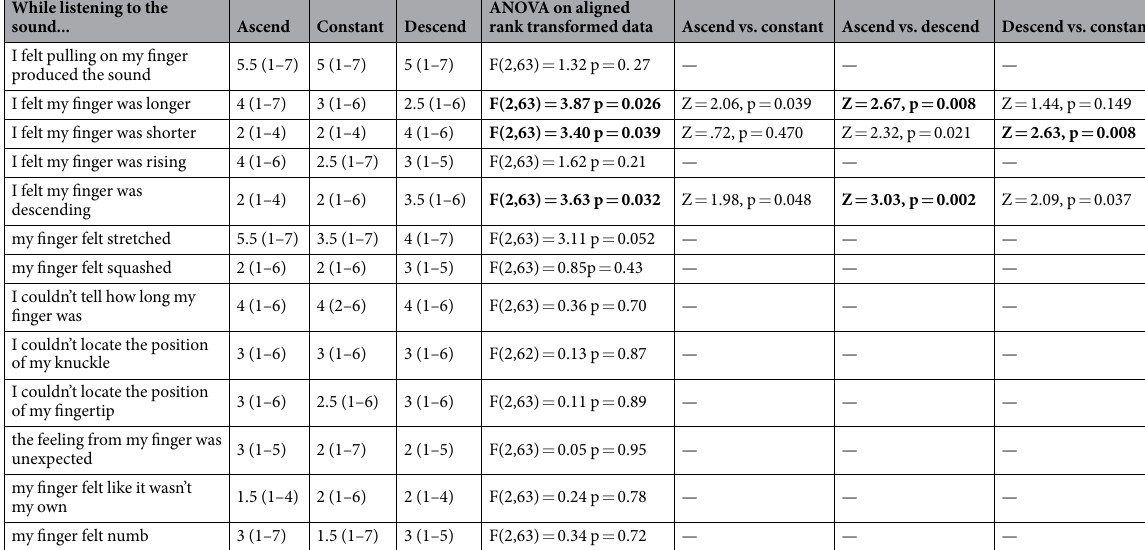
Table 2. Median (Range) for questionnaire data in Experiment 1. Participants rated their level of agreement with the statements using a 7-item Likert scale (1 to 7). Results from ANOVA on aligned rank transformed data comparing three conditions are in the fifth column. Significant differences are marked in bold font. Significant tests were followed by Wilcoxon signed ranked tests that are presented in columns six-eight (with correction for multiple comparisons α =